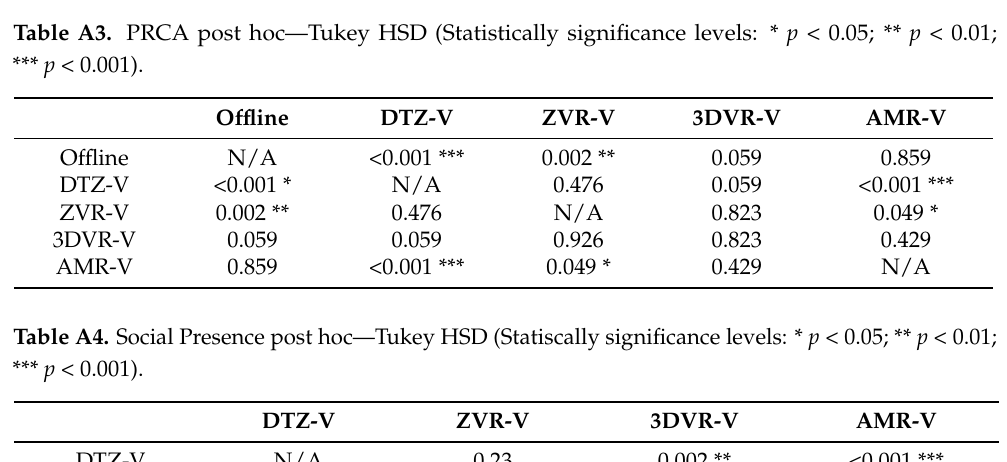
Table A3. PRCA post hoc—Tukey HSD (Statistically significance levels: * p < 0.05; ** p < 0.01;